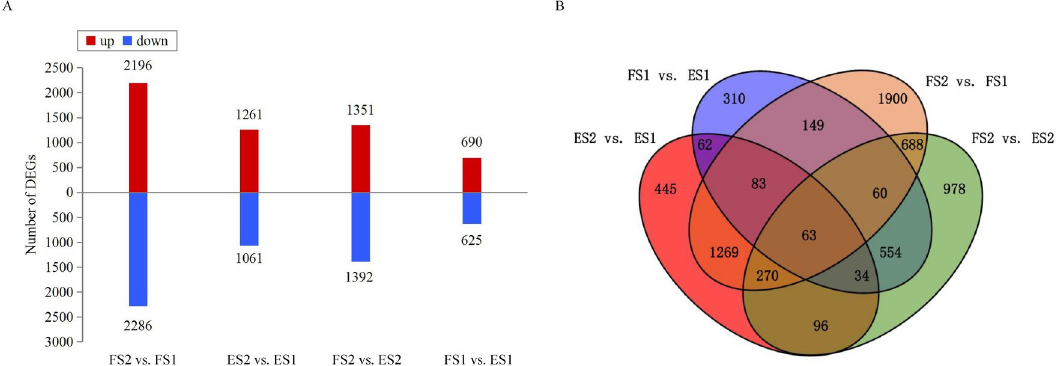
Fig 3. DE mRNA analyses. (A) Numbers and levels of DEGs in the four comparisons. (B) Venn diagram of DE mRNAs among the four comparisons.